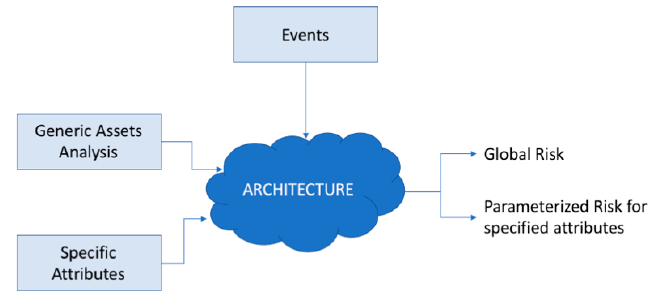
Figure 2. Design methodology followed for the architecture development.